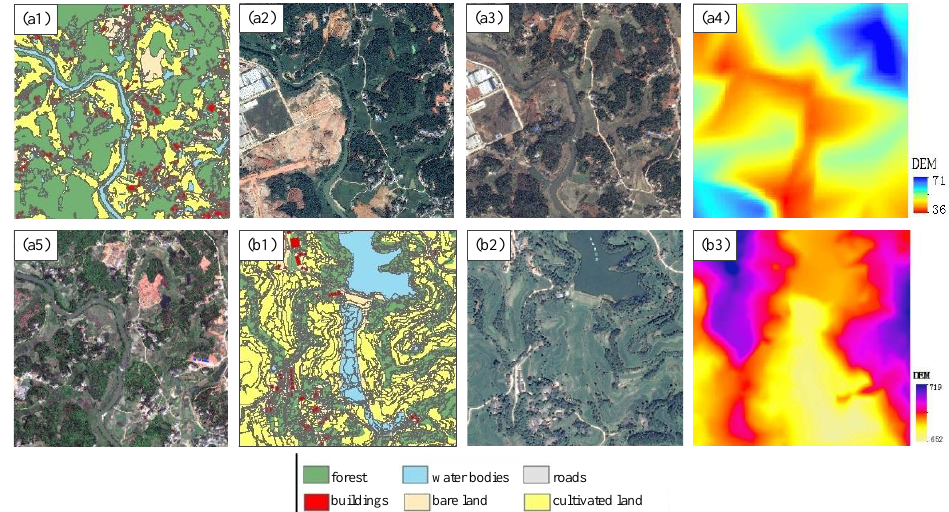
Figure 5. Data in two study areas. ( a1 – a5 ) are the data in the study area A, and ( b1 – b3 ) are the data in the study area B. ( a1 ) The vector data in March 2009; ( a2 ) the QuickBird images on 18 September 2017; ( a3 ) the aerial images on 08 February 2016; ( a4 ) digital elevation model (DEM) in the study area A; ( a5 ) the QuickBird images on 20 April 2009; ( b1 ) the vector data in April 2014; ( b2 ) the QuickBird images on 14 August 2016; and ( b3 ) digital elevation model (DEM) in the study area B.